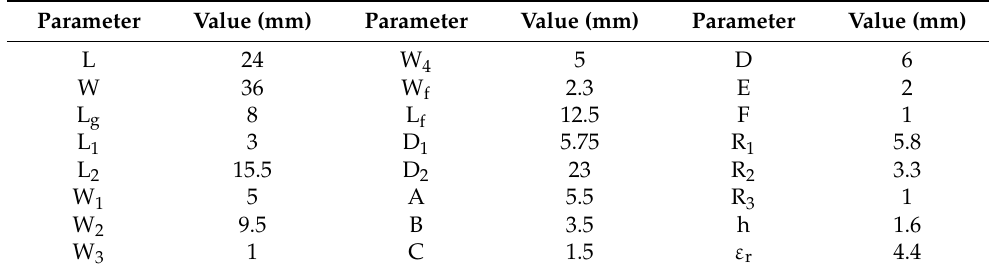
Figure 2. S–parameters response.